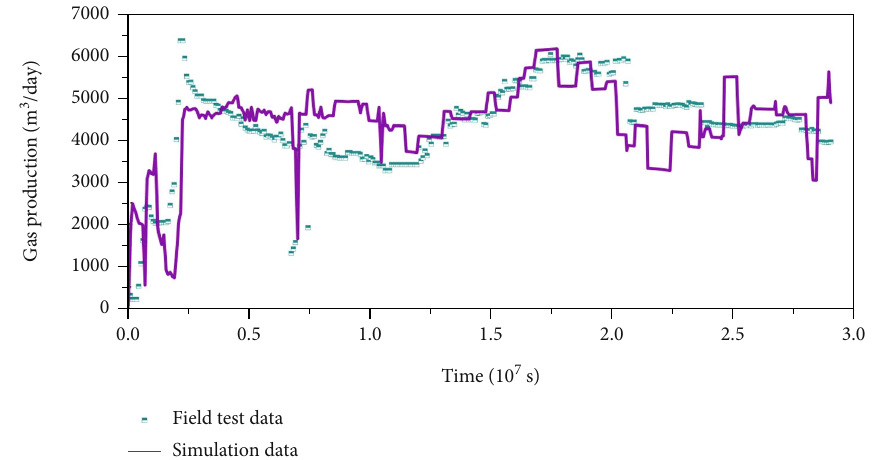
Figure 7: Comparison of our model and the fi eld test